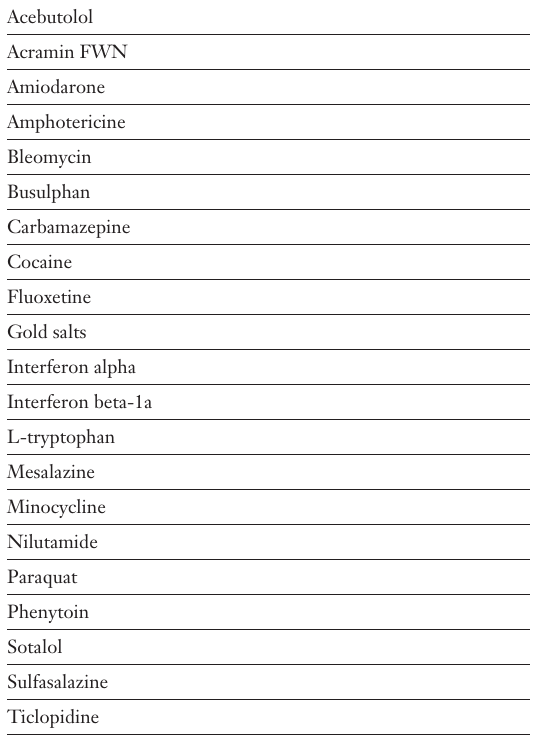
Drugs identified as cause of organising pneumonia (adapted from reference